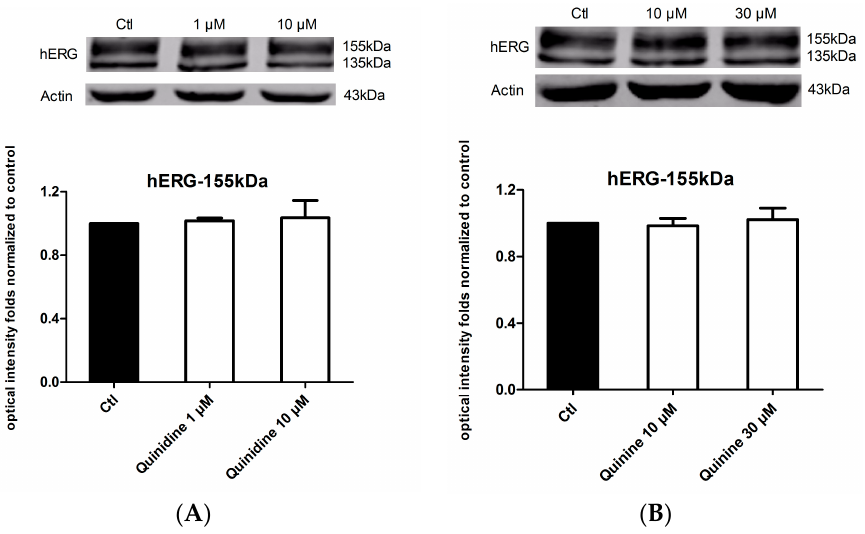
Figure 5. Effects of quinidine and quinine on hERG expression. ( A ) hERG expression levels in hERG- HEK cells under control conditions or 1 μ M/10 μ M quinidine treatment for 24 h. Mature hERG protein was not affected by 1 μ M/10 μ M quinidine. n = 5; ( B ) hERG expression levels in hERG-HEK cells under control conditions or 10 μ M/30 μ M quinine treatment for 24 h. Mature hERG protein was not affected by 10 μ M/30 μ M quinine. n = 5. Abbreviation: ctl, control.